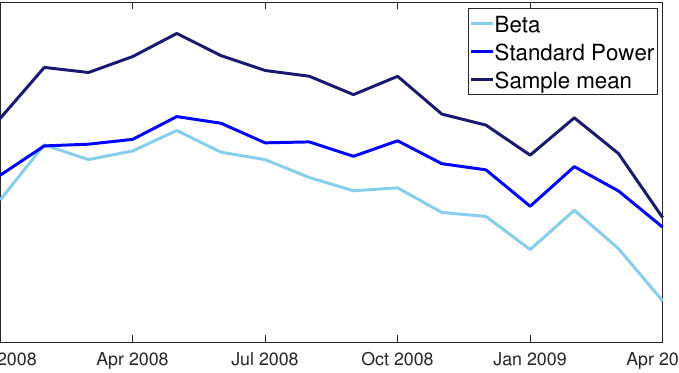
Figure 7. The fitted mean of the beta and standard power distributions excluding observations between 0 and 1. The scale on the vertical axis is